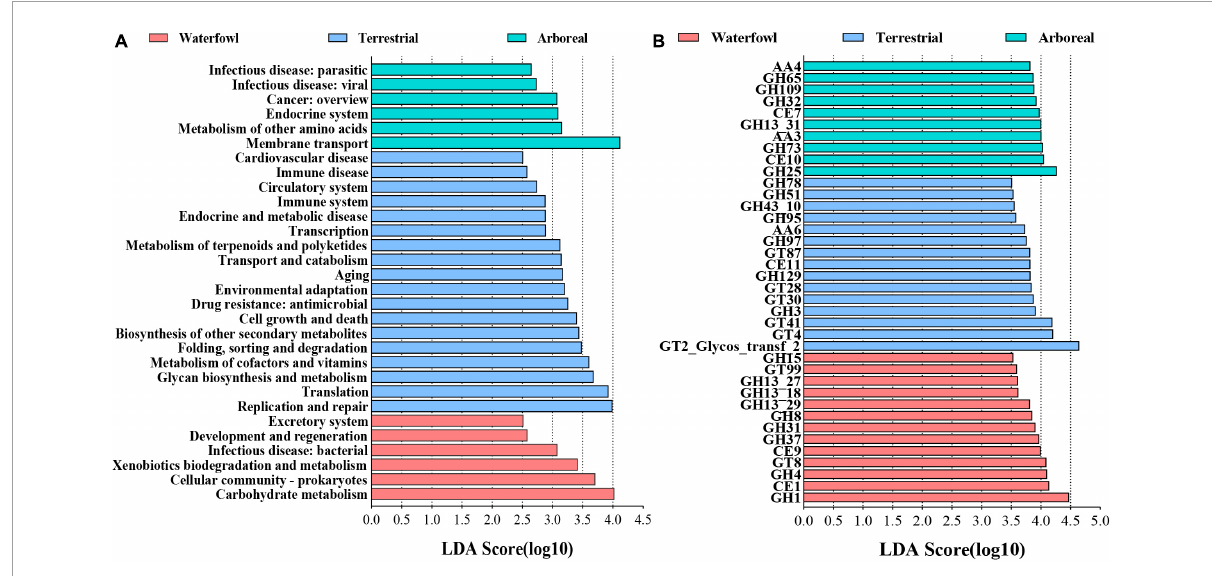
FIGURE6 Linear discriminant analysis (LDA) effect size (LEfSe) analysis of KEGG level 2 (A) and CAZy (B) between the different ecological types of birds. GT, glycosyl transferases; CE, carbohydrate esterases; GH, glycoside hydrolases; AA, auxiliary activities. LDA > 2.